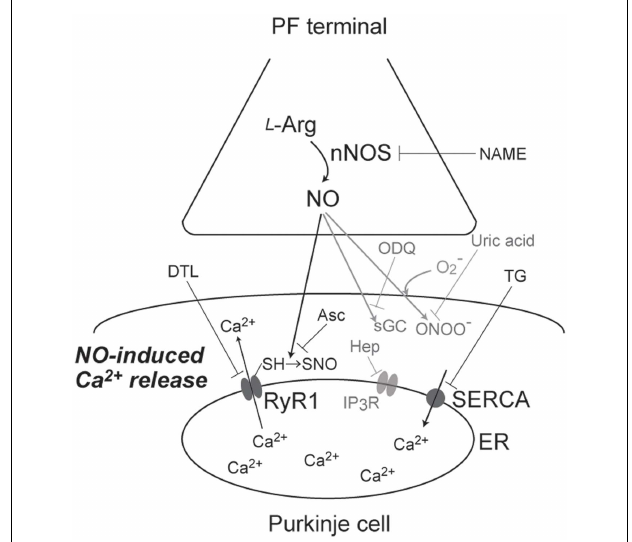
FIGURE 1 |A schematic diagram of signaling pathways for NO-induced Ca 2 + release . NO, produced at PF terminal, diffuse and induce Ca 2 + increase in Purkinje cell.This NO-induced Ca 2 + increase is sensitive to NAME (broad NOS inhibitor), Asc (reducing reagent), DTL (RyR1 antagonist), andTG (SERCA inhibitor), but not affected by ODQ (sGC inhibitor), heparin (IP 3 R antagonist), and uric acid (peroxynitrite scavenger). Thus, the Ca 2 + increase is revealed to be Ca 2 + release mediated by S-nitrosylation of RyR1 by endogenous NO.